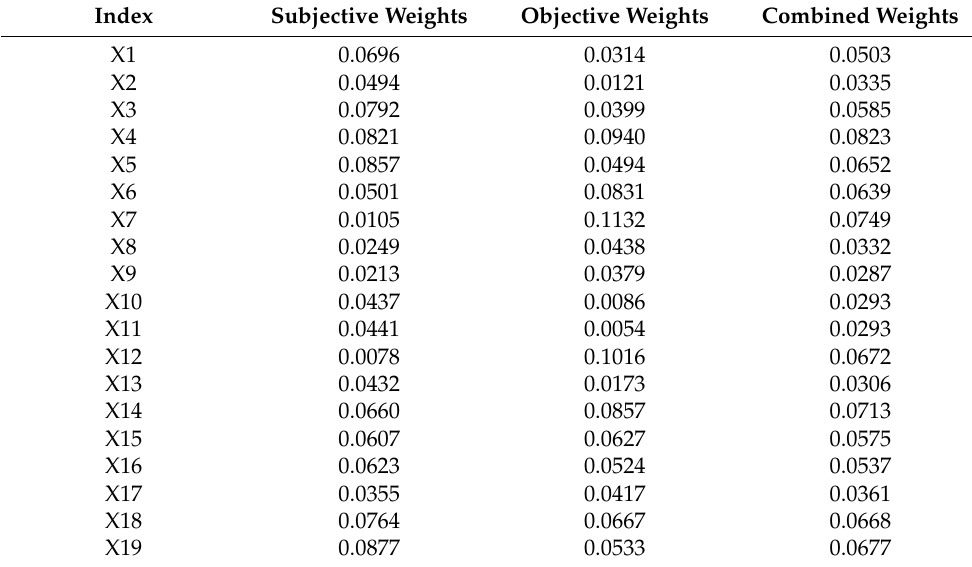
Table 4. Influence degree, being influenced degree, centrality degree, and reason